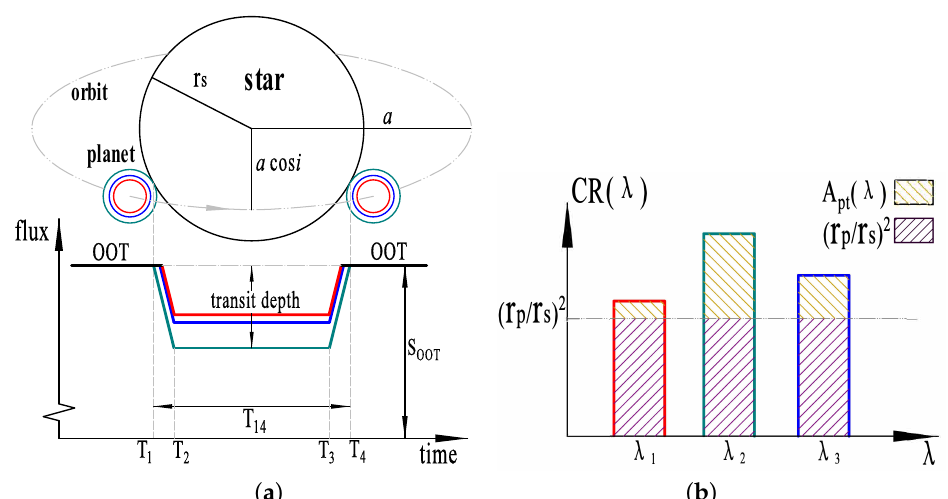
Figure 1. ( a ) Primary transit spectroscopy with light curves at different wavelengths. T 2 and T 3 indicate the time when the planetary projection completely enters and just exits the star. ( b ) Chart of contrast-ratio composition. Contrast ratio is composed of constant planetary component ( r p / r s ) 2 , as indicated by the horizontal line, and wavelength-dependent atmospheric contribution A pt ( λ ) . Red, blue, and green lines represent observation results at different